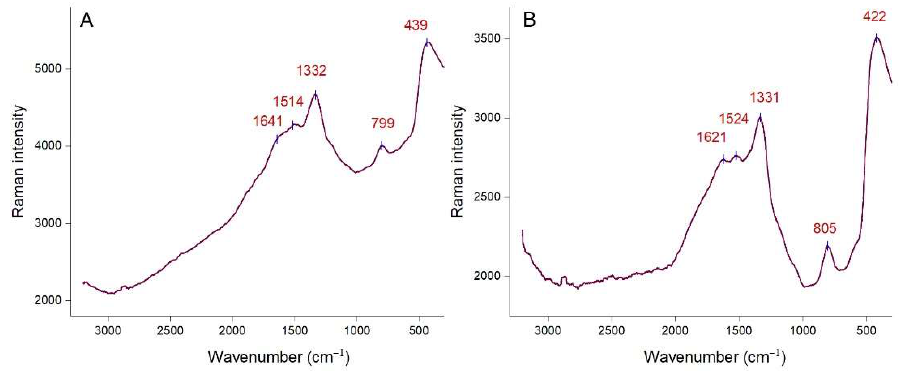
Figure 4. Raman spectra of Picea abies ( A ) and Pinus nigra ( B ) bark extract derived